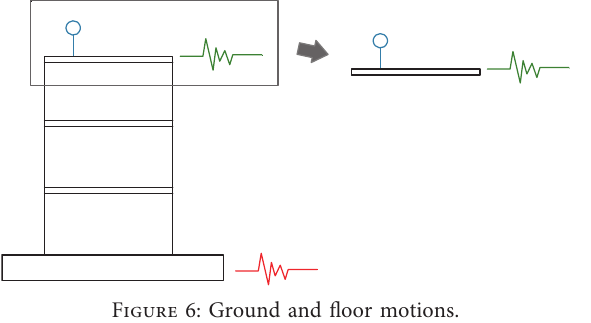
Figure 6: Ground and floor motions.